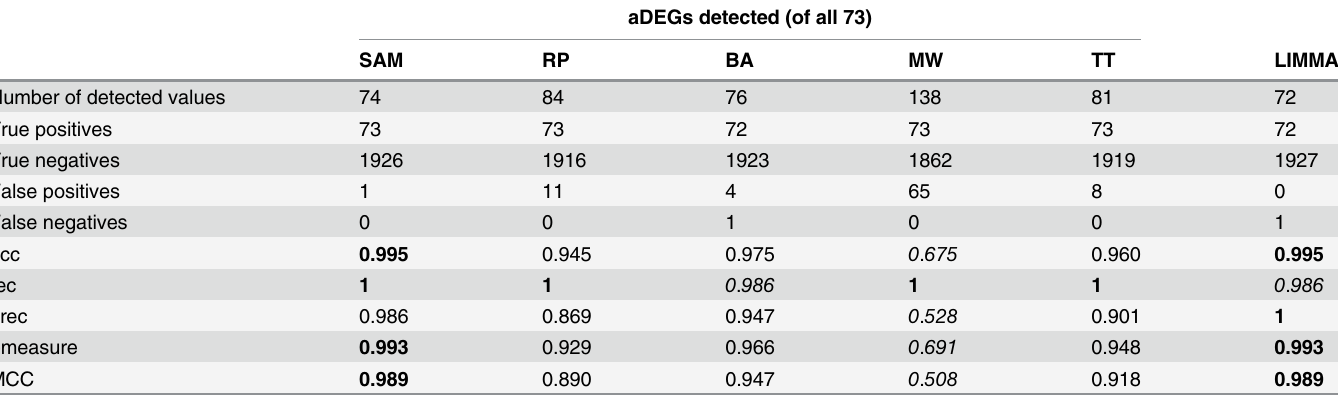
Table 5. Number of aDEGs detected and assessment parameters used for each method in Dataset1 (in bold — the best, in italics — the worst). aDEGs detected (of all